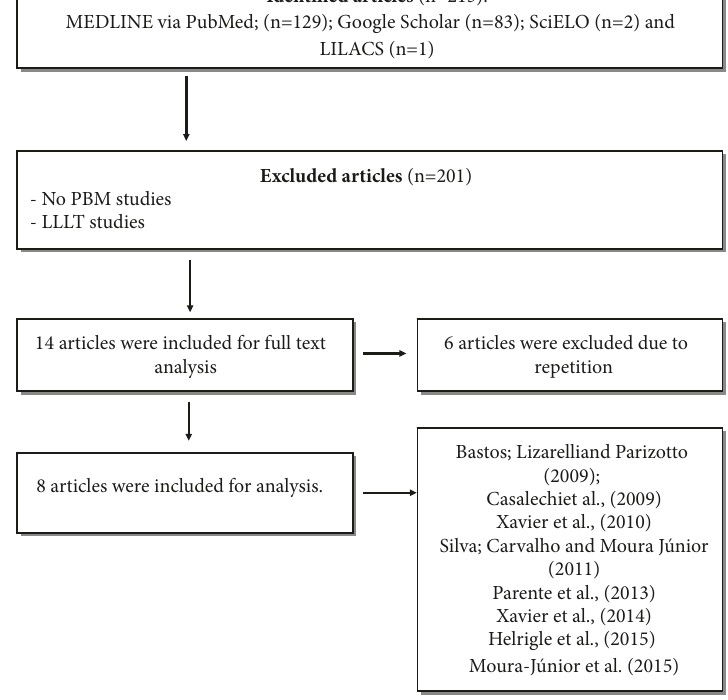
Figure 1: Selection flowchart of the studies used in the review of literature on the use of LED in tendon